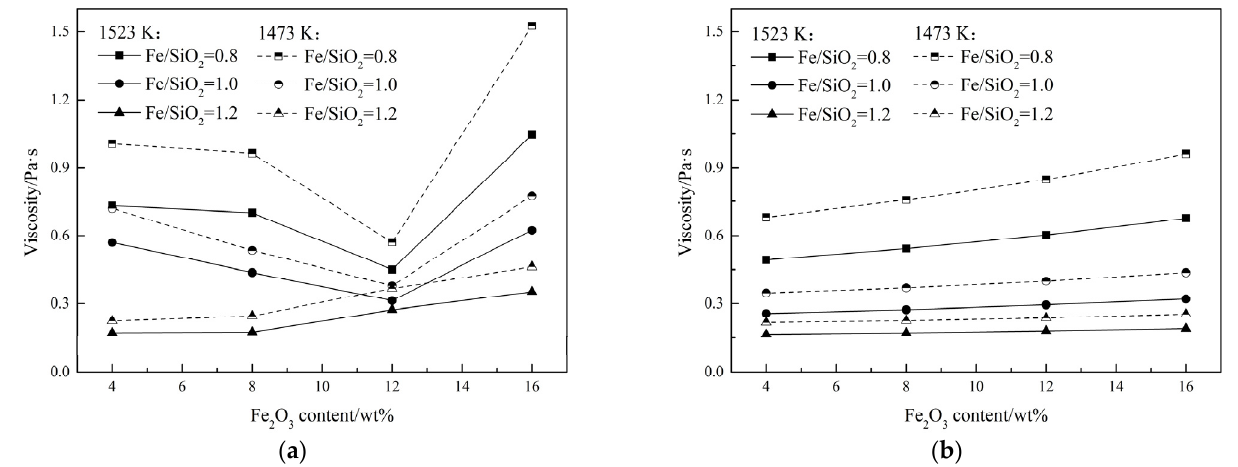
Figure 11. Effect of Fe 2 O 3 on the FeO − Fe 2 O 3 − SiO 2 − 8 wt%CaO − 3 wt%MgO − 3 wt%Al 2 O 3 slag viscosity at fixed temperatures and Fe/SiO 2 ratios: ( a ) results of experimental tests; ( b ) results of simulation tests by Factsage 7.3.